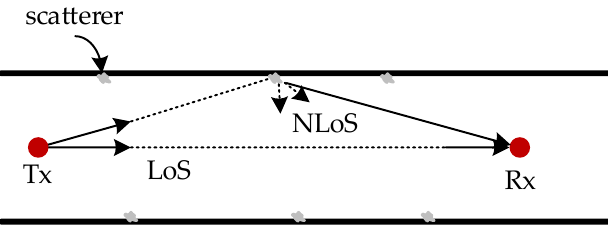
Figure 4. Channel model based on geometric space random scatter.